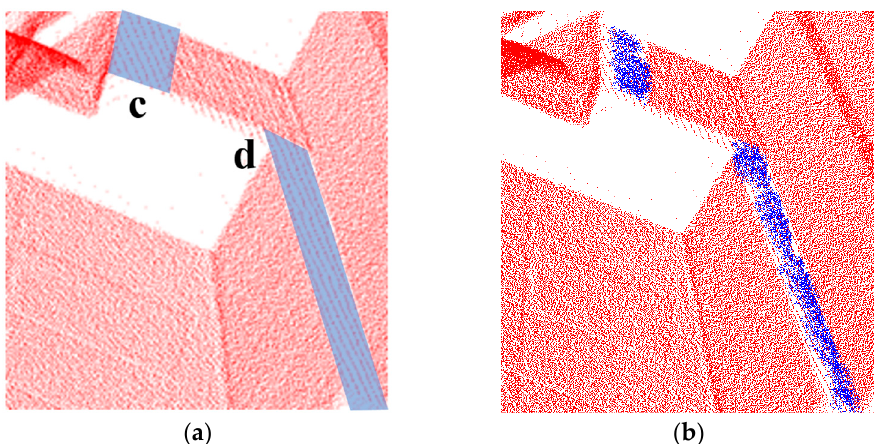
Figure 23. TLS point cloud facade patching effect. ( a ) The facade hole of the TLS point cloud. ( b ) TLS point cloud facade hole repair effect. Red point cloud is TLS point cloud, the blue point cloud indicates the point cloud extracted from HLS to repair the facade hole. The ‘a b c d’ in the figure is the hole number in reference to Figure 22.